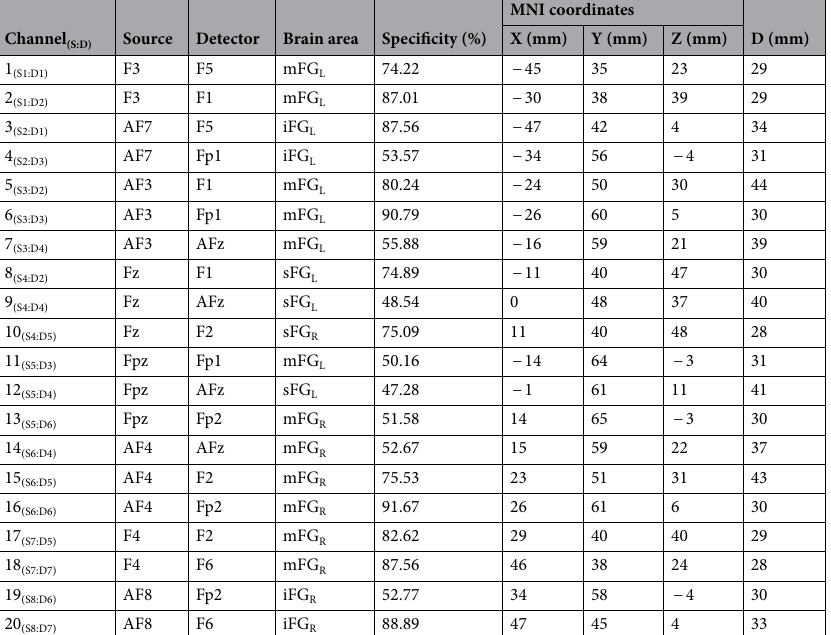
Table 5. fNIRS positions and brain locations. Channels and Source–Detector (S:D) locations using Montreal Neurological Institute (MNI) coordinates (X, Y, and Z), with the brain area designation according to International 10–20 system of source–detector location designation. Brain Areas include inferior, middle, and superior (i, m, s) regions of Frontal Gyrus (FG) in either Left or Right hemispheres (L or R). Last column represents distance between source and